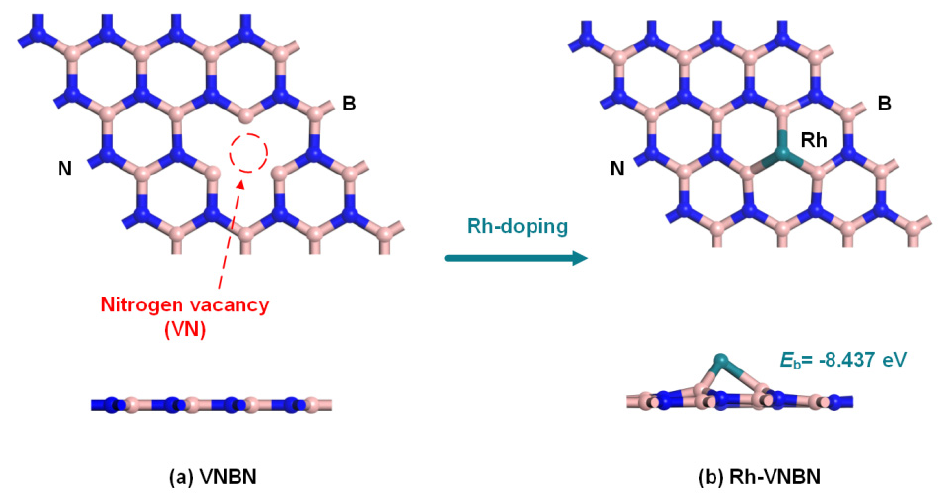
Figure 2. Configurations of the Rh-doped nitrogen vacancy BN monolayer. The red circle represents the nitrogen vacancy. ( a ) VNBN, ( b ) Rh-VNBN.